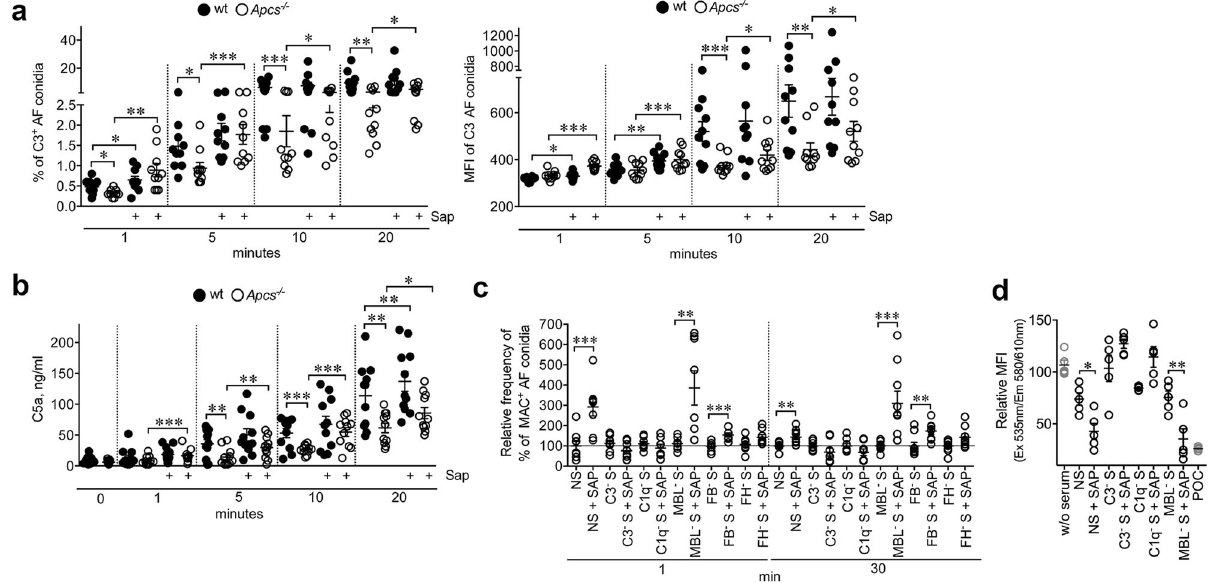
Fig. 4 SAP-mediated complement activation on A. fumigatus . a FACS analysis (frequency, left; MFI, right) of C3 from wt ( − , n = 10; + Sap, n = 10) and Apcs − / − ( − , n = 10; + Sap, n = 10) mouse plasma on AF conidia (1 × 10 7 ) opsonized or not with murine SAP. a Left, wt vs. Apcs − / − , * P = 0.01 (1 min), * P = 0.02 (5 min), *** P = 0.003 (10 min), ** P = 0.007 (20 min). wt vs. wt + Sap, * P = 0.02 (1 min). Apcs − / − vs. Apcs − / − + Sap, ** P = 0.008 (1 min), *** P = 0.003 (5 min), * P = 0.05 (10 min), * P = 0.05 (20 min) (two-sided, unpaired t -test). a Right, wt vs. Apcs − / − , ***, P = 0.002 (10 min), ** P = 0.006 (20 min). wt vs. wt + Sap, * P = 0.01 (1 min), ** P = 0.005 (5 min). Apcs − / − vs. Apcs − / − + Sap, *** P = 0.0003 (1 min), *** P = 0.002 (5 min), * P = 0.04 (10 min and 20 min) (two-sided, unpaired t -test). b Murine plasma C5a levels after incubation with AF conidia shown in a . n = 11 mice/genotype. wt vs. Apcs − / − , ** P = 0.008 (5 min), *** P = 0.003 (10 min), ** P = 0.005 (20 min). wt vs. wt + Sap, ** P = 0.009 (20 min). Apcs − / − vs. Apcs − / − + Sap, *** P = 0.003 (1 min), ** P = 0.007 (5 min), *** P = 0.002 (10 min), * P = 0.04 (20 min) (two-sided, unpaired t -test). a , b A representative independent experiment shown out of 3 performed. Each spot represents plasma from a single mouse. a , b Mean ± SEM. c FACS analysis of SAP-mediated MAC deposition on AF conidia (1 × 10 7 ) in the presence of human sera depleted of complement components. Mean ± SEM of two experiments in quadruplicate and merged out of 4 performed. Each spot corresponds to a replicate. NS vs. NS + SAP, *** P = 0.001; ** P = 0.008 (two-sided, unpaired t -test). MBL − S vs. MBL − S + SAP, ** P = 0.006; *** P = 0.003 (two-sided, unpaired t -test). FB − S vs. FB − S + SAP, *** P = 0.002; ** P = 0.009 (two-sided, unpaired t -test). d Quantitative analysis of AF viability performed using a resazurin-based assay. AF viability assay performed in sera depleted of complement components. Results are mean ± SEM of the relative fl uorescence intensity. Effect of Posaconazole (POC; 1 µ M) exposure is also shown. Figure summarizes one experiment out of 5 performed with n = 5 replicates each. * P = 0.01; ** P = 0.009 (two-sided, unpaired t